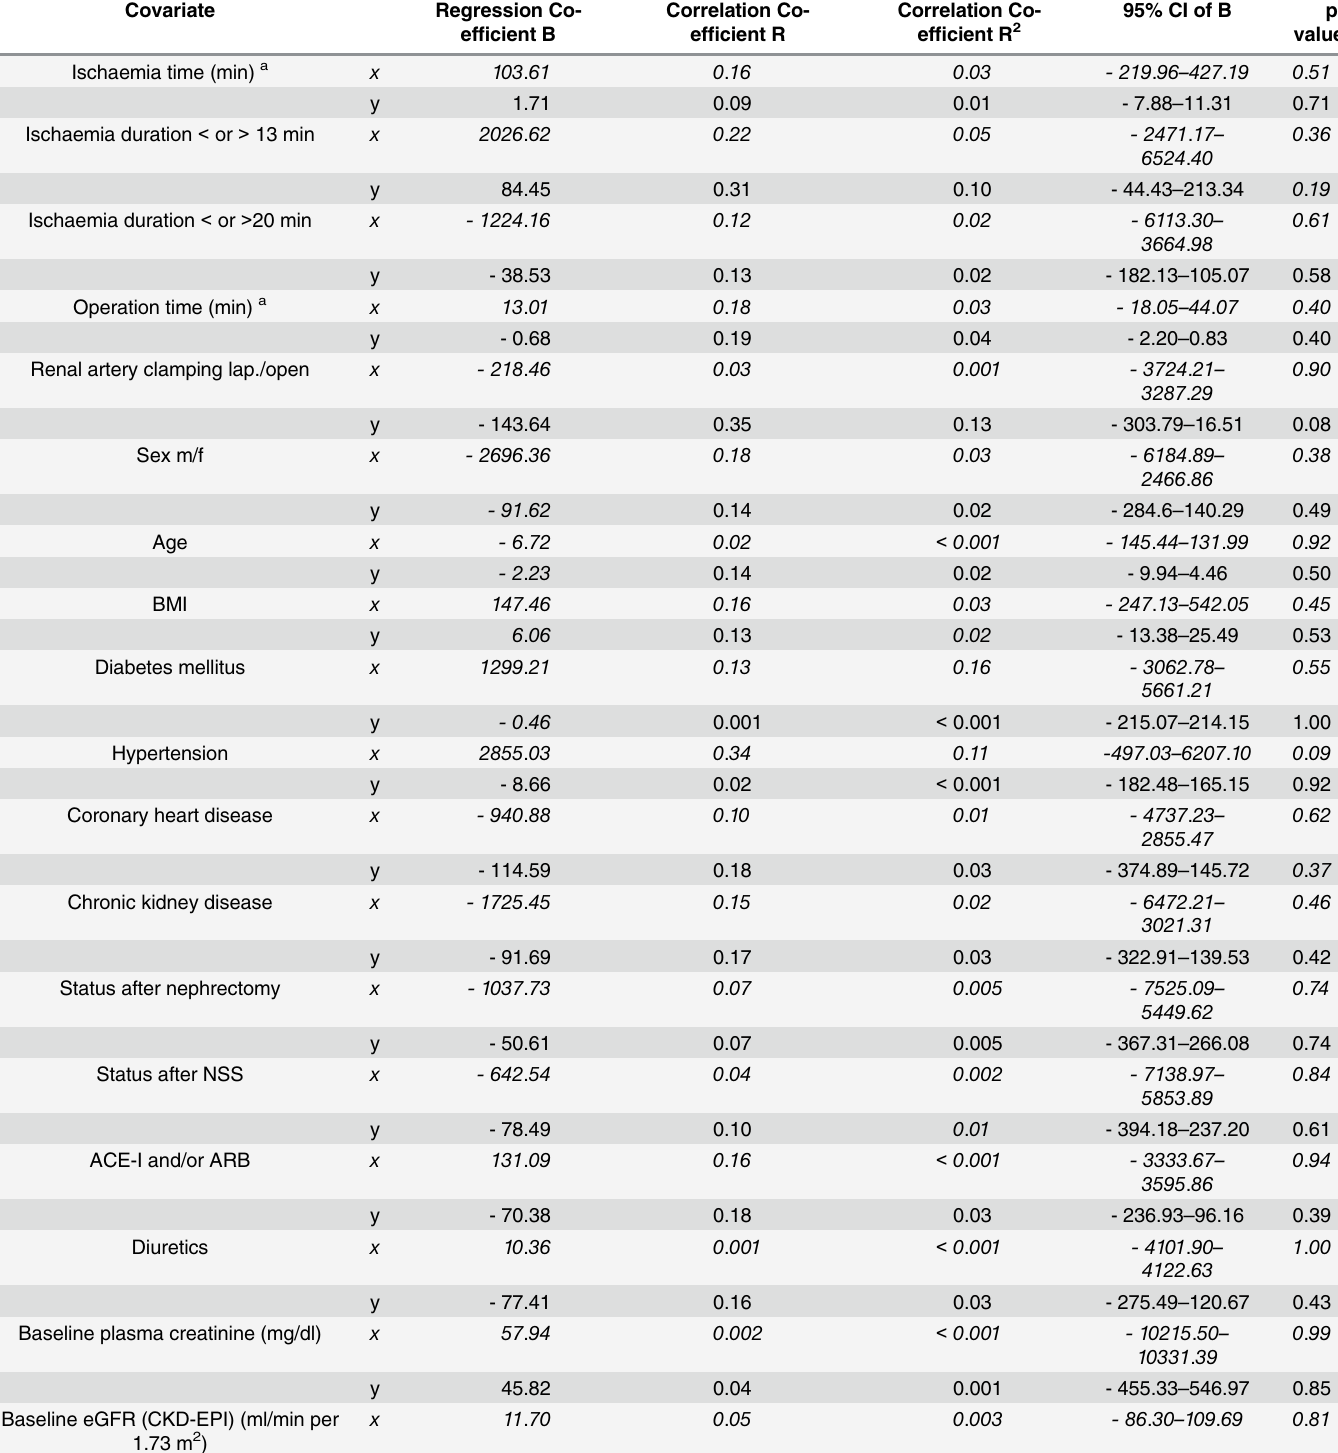
Table 2. Univariate linear regression analysis for prognostic factors of the maximum urinary calprotectin increase ( x — italics top line ) and the max- imum urinary NGAL increase (y — bottom line) in Group 1 patients (NSS with renal